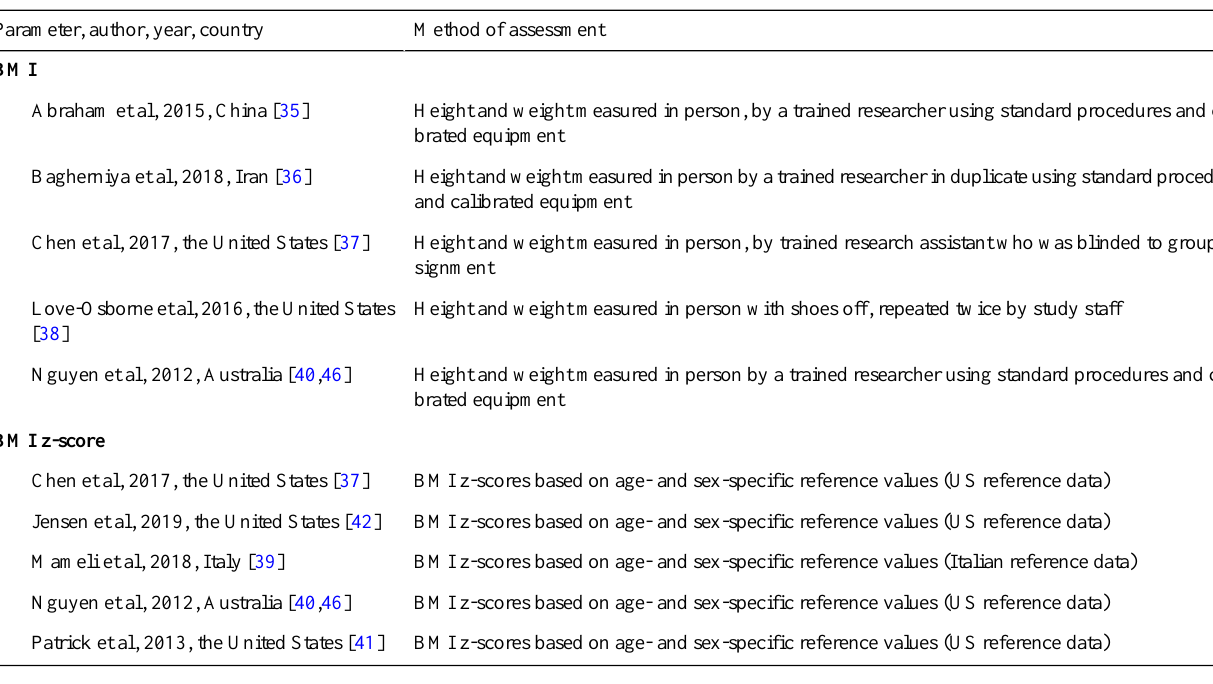
Table 2. Method of BMI and BMI z-score assessment